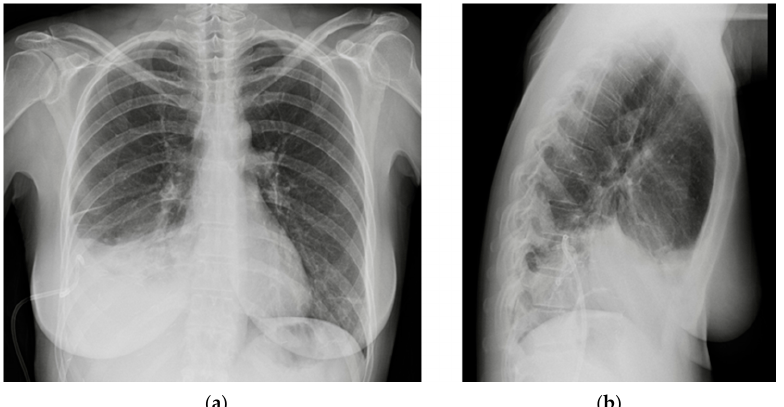
Figure 31. Image of a pig-tail chest tube inserted through the right lateral chest wall draining a right basal pulmonary effusion. Note that in this case, the lateral view ( b ) depicts the tube loops more clearly than PA view ( a ); also, there seems to be an effect given by the uplifting of the arms in the lateral view, with the insertion point of the tube being dragged upward and so “emphasizing” its looping appearance. Table 6. Chest tubes’ most frequent CXR-detectable anomalies and complications.